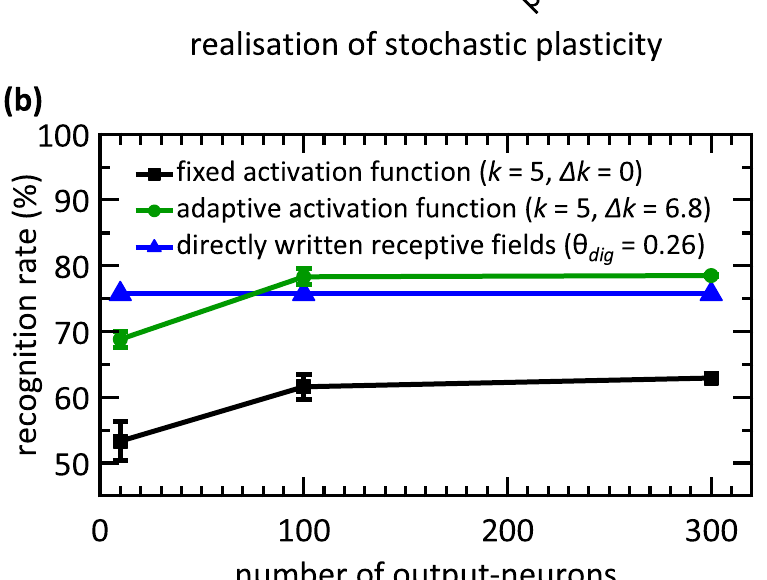
MNIST test set are depicted in Fig. 7(b). This shows that for stochastic networks with over 100 neurons in the output layer, slightly higher recognition rates are obtained than when the receptive fields are directly written. Furthermore, a detailed examination of the learned receptive fields shows that the stochastic learning scheme leads to more graded fields, which might be of interest for networks with more layers, and results in the slightly improved classification performance.